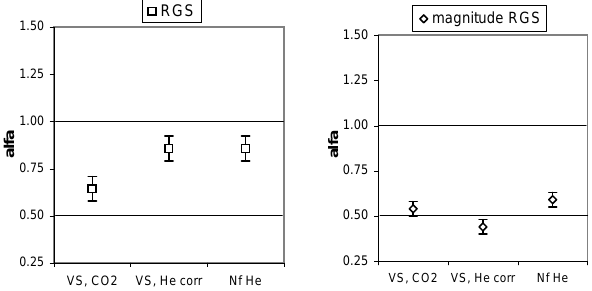
Fig. 14. Values of α exponent for the chemical RGS and related magnitude series. Labels in abscises are: “VS CO2 ” the CO 2 concentration series of VS site; “VS He corr. ” the He concentration series of VS site, once filtered out the dissolution effects; “Nf He ” the He concentration series of site Nf. The calculated exponents have been corrected by the estimated accuracy errors (see Sect . 3.3) hence they can be directly compared to the theoretical values of flicker and white noise (solid horizontal lines).